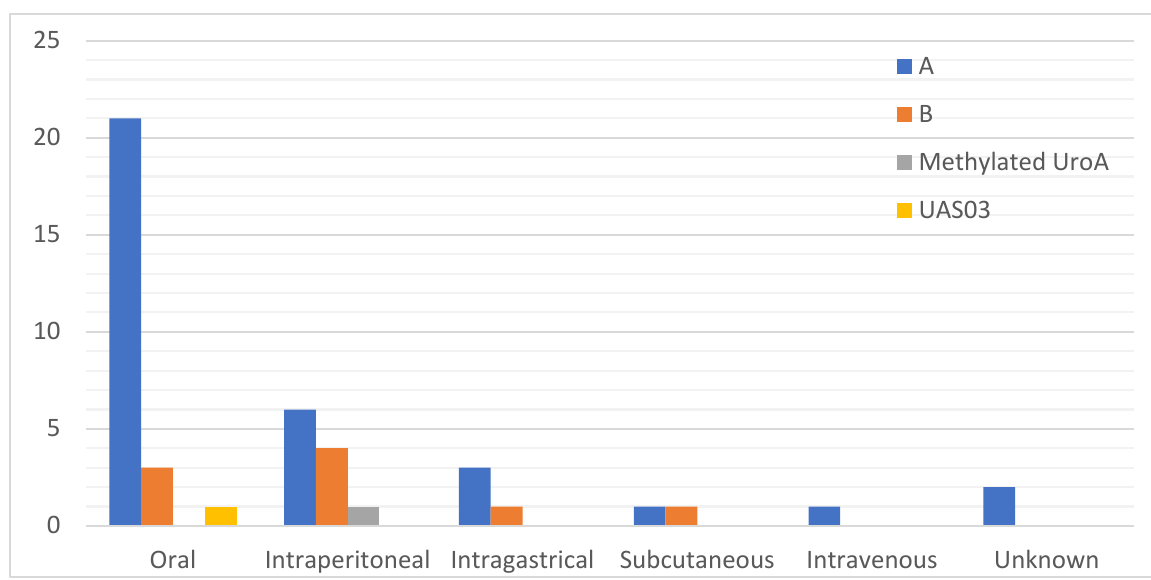
Figure 1. PRISMA flow diagram for the article selection process.